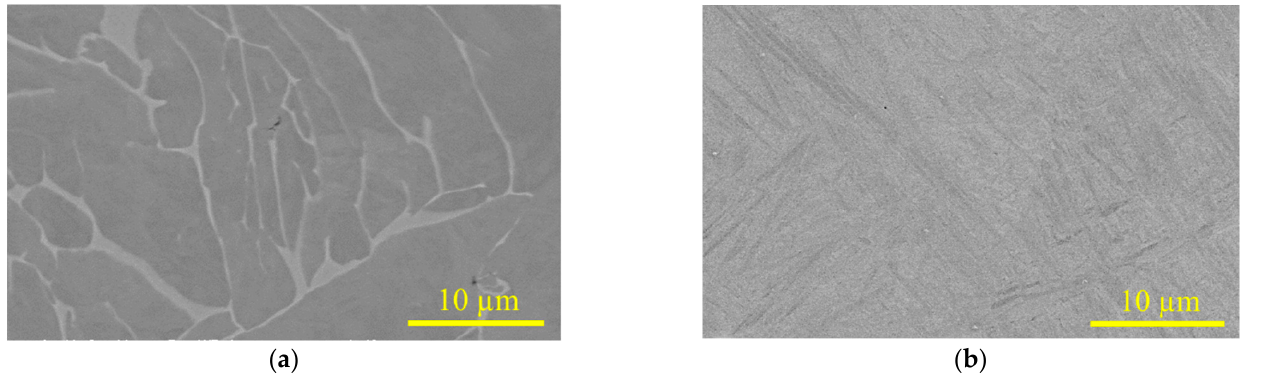
Figure 10. Backscatter electron image of polished samples in unetched conditions, ( a ) PM and ( b ) L-PBF sample.